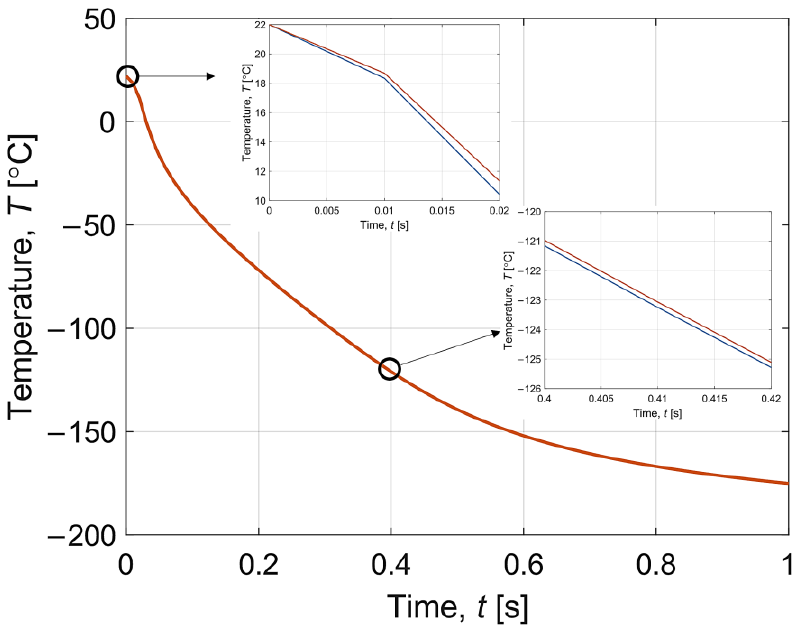
Figure 6. History of interval temperature during cooling in time 0 – 1 s.